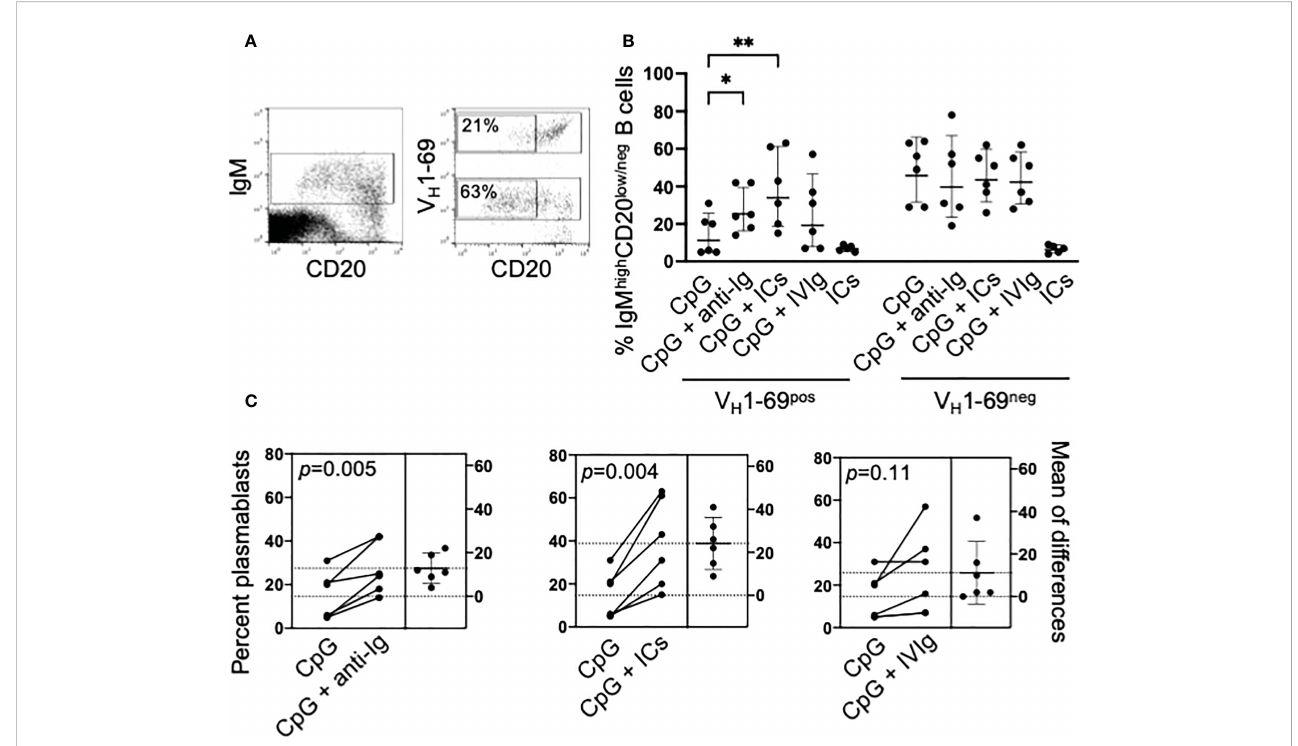
FIGURE 2 Co-stimulation with CpG and ICs drives the differentiation into IgM high CD20 low/neg B cells of unresponsive V H 1-69 pos B cells. (A) Representative cytograms illustrating the gating strategy. PBMC from an MC patient were stimulated for 5 days with CpG and IgM pos B cells were electronically gated; VH1-69 pos and VH1-69 neg cells were further gated and, in each population, the frequency of IgM high CD20 low/neg B cells was calculated. (B) Cumulative results of differentiation of VH1-69 pos and VH1-69 neg IgM B cells into IgM high CD20 low/neg B cells induced by different stimuli; *p=0.03, **p=0.0036 by nonparametric Friedman test. (C) Estimation plots of changes in the percentage of IgM high CD20 low/neg B cells after different stimuli in individual patients; p-values are calculated by paired t